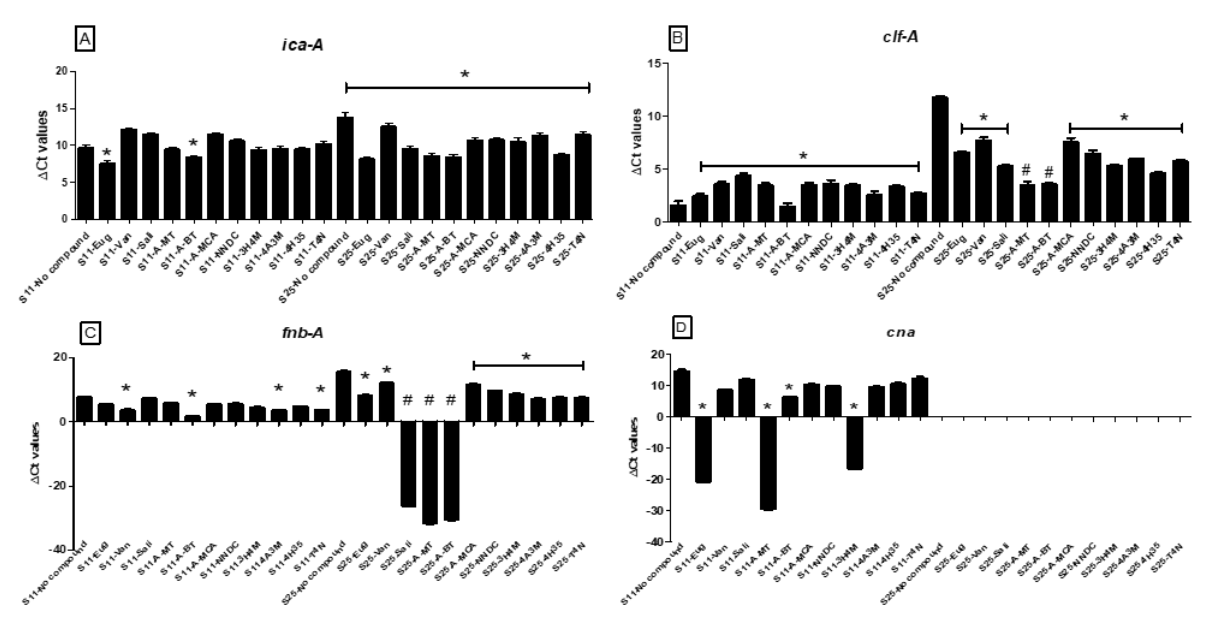
Figure 2. Expression of genes associated with biofilm formation in treated and untreated samples. The expression ( ∆ Ct) of ( A ) ica -A, ( B ) clf -A, ( C ) fnb -A, and ( D ) cna genes in sensitive (S11) and resistant (S25) isolates with and without all 11 test compounds treatment. The asterisk * indicates p -value < 0.05 and # indicates p -value <0.001.